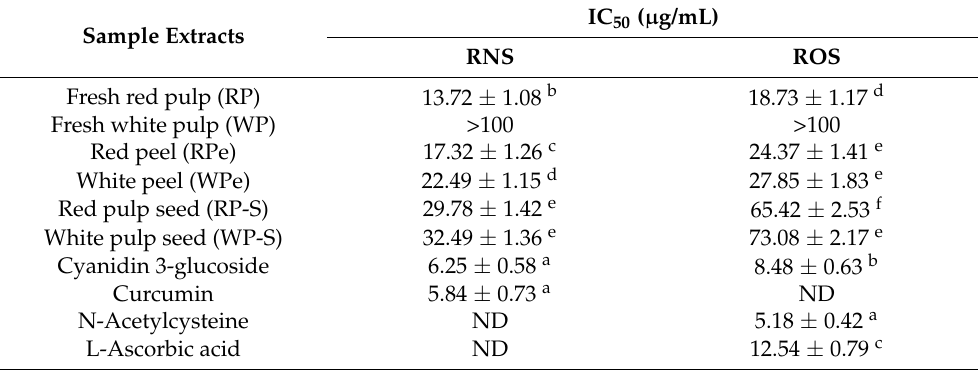
Figure 3. HPLC chromatograms of mixed catechin and related compounds and the extract of the seeds of red pulp (RP-S). The peaks indicate ( a ) gallic acid, ( b ) pyrogallol, ( c ) gallocatechin, ( d ) epi- gallocatechin, ( e ) caffeine, ( f ) catechin, ( g ) epicatechin, ( h ) epigallocatechin gallate, ( i ) gallocatechin gallate, and ( j ) epicatechin gallate. Table 2. The 50% inhibitory concentrations ( µ g/mL) of extracts for the production of reactive nitrogen species (RNS) and reactive oxygen species